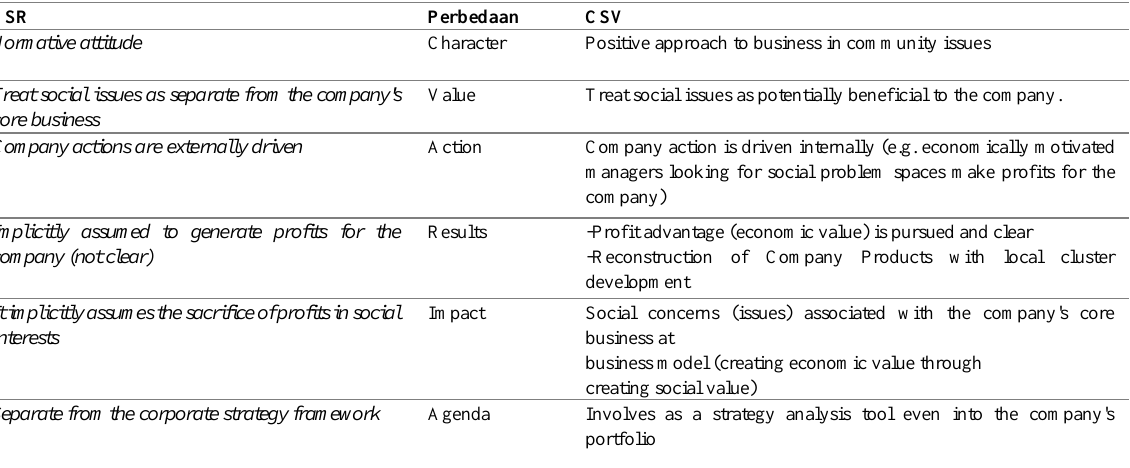
Table 1: The difference between CSR and